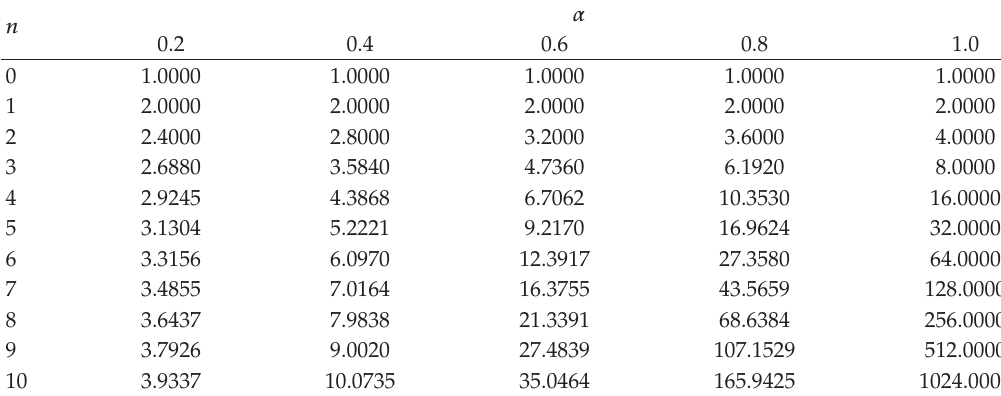
Table 1: Numerical solution of (cid:7) 4.17 (cid:8)